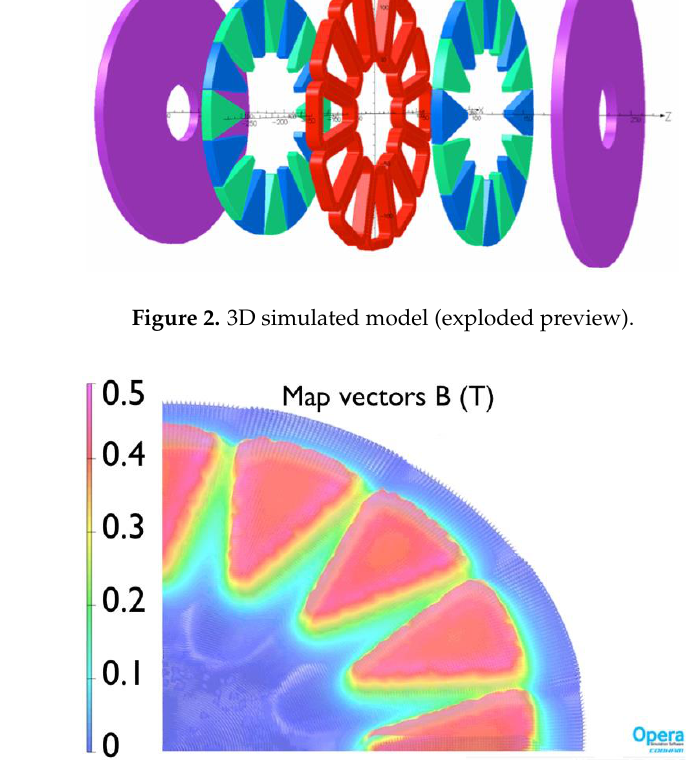
Figure 3. Magnetic flux distribution in the middle of the air gap in absolute values.